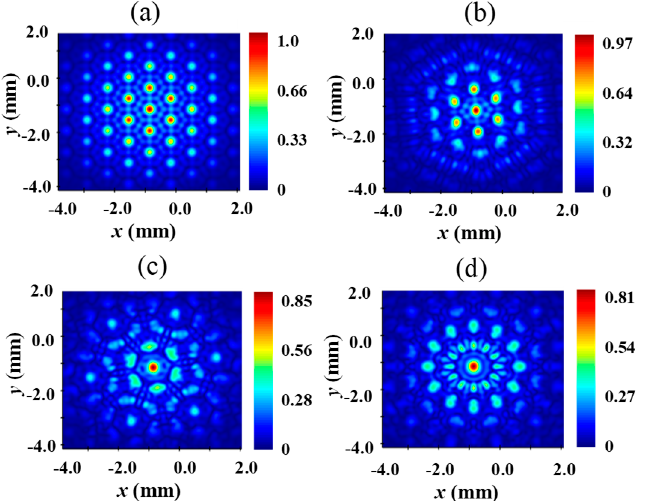
Figure 4. Numerically obtained electric field distribution in near-field in the case of: ( a ) 0° rotation; ( b ) 10° rotation; ( c ) 20° rotation; ( d ) 30° rotation.